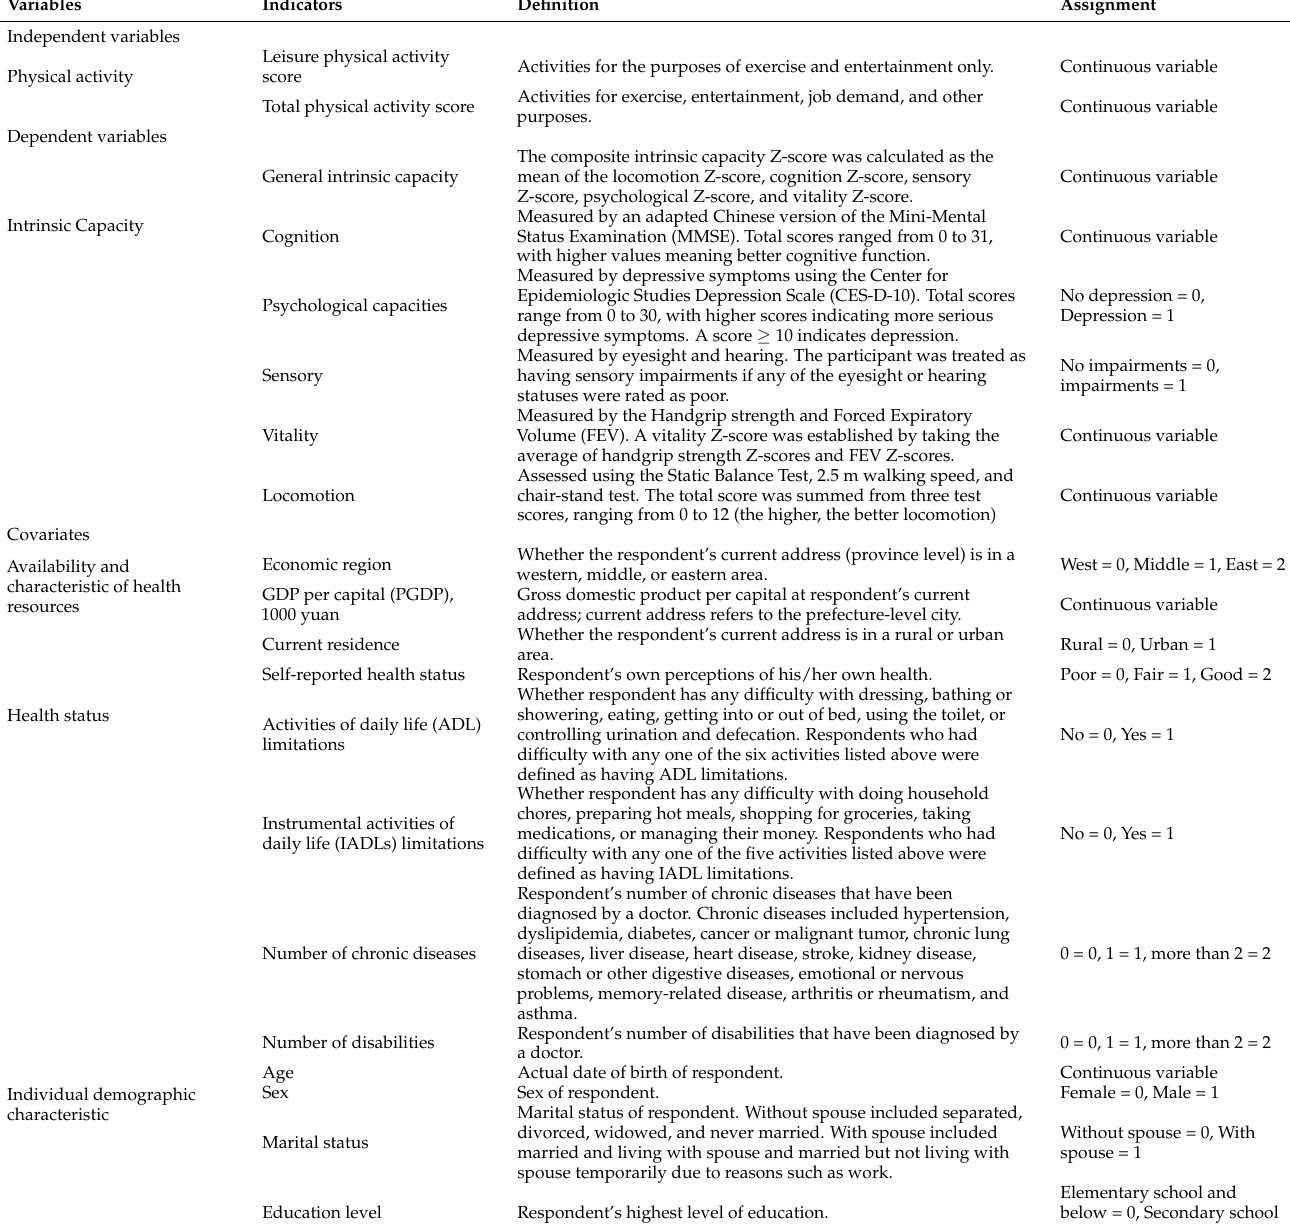
Table A1. Definitions and assignments of all